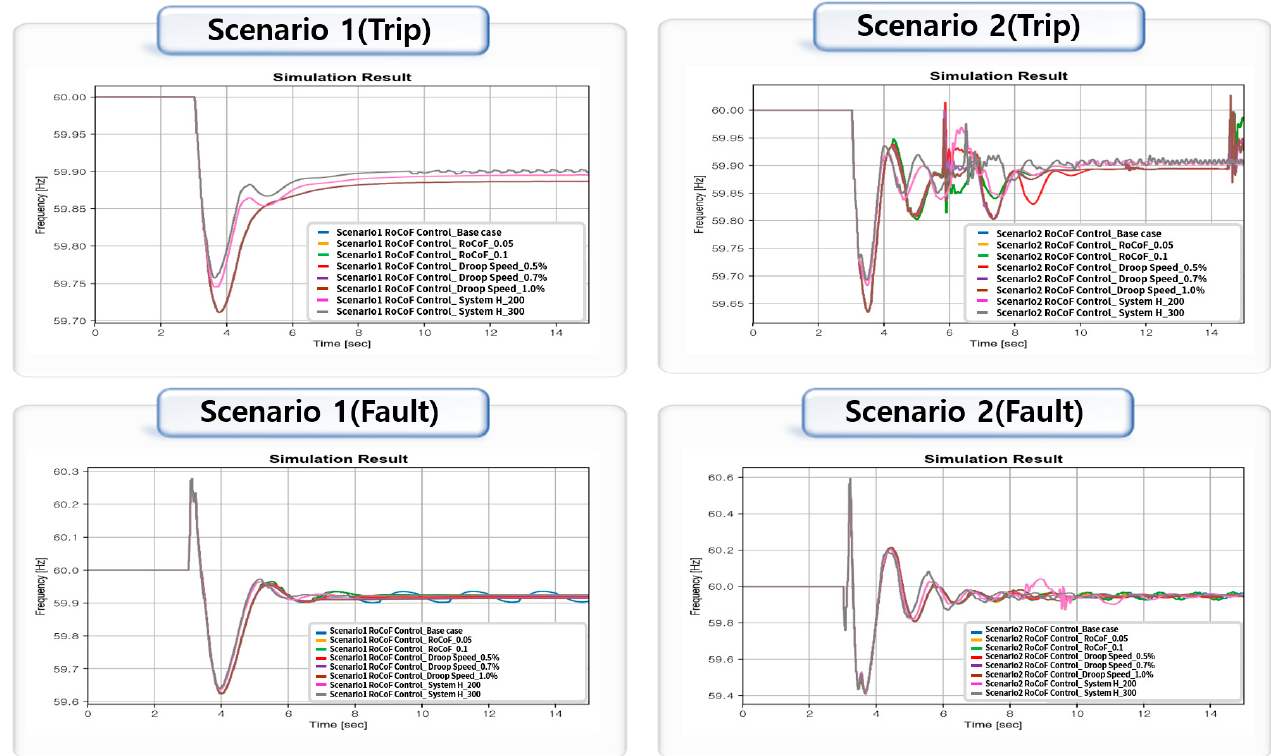
Figure 11. Frequency response by ESS parameter (RoCoF control).